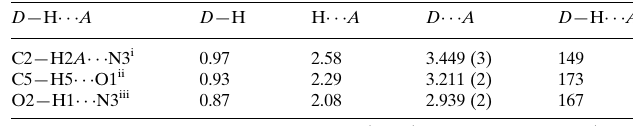
Hydrogen-bond geometry (A˚ , (cid:3)